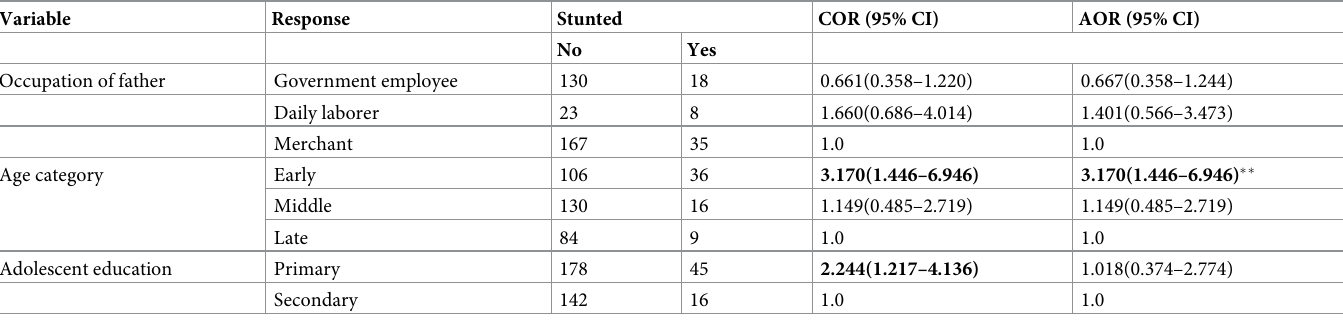
Table 4. Bivariable and multivariable logistic regression of factors associated with stunted among urban school adolescent girls, 2020 (n = 381).